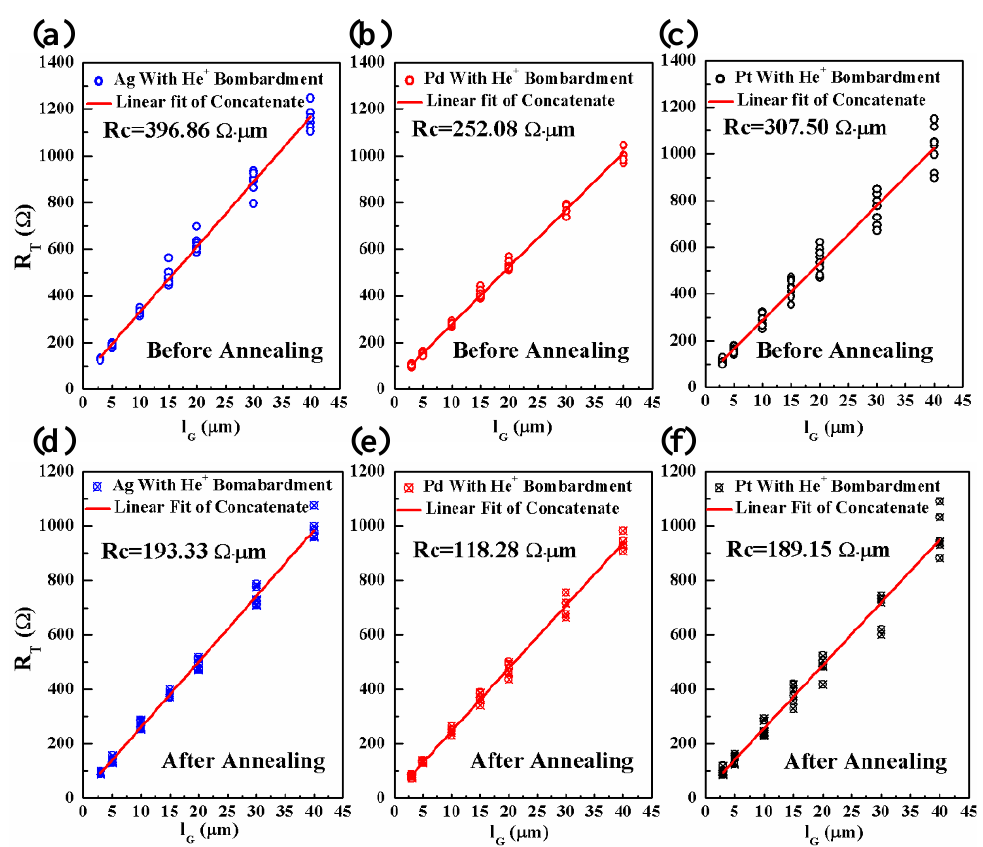
Figure 8. The linear plots of R T vs. l G for the Ag, Pd, and Pt/graphene contacts with He + bombardment before annealing ( a – c ) and after annealing ( d – f ). For each l G , 10 data points are used and the liner fitting is performed using concatenate fit method. Extracted R c value is shown in each corresponding plot.